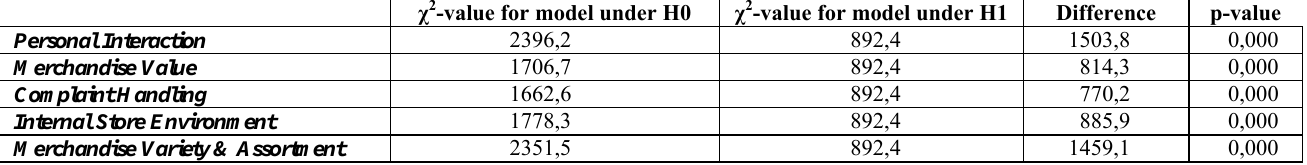
χ 2 -value for model under